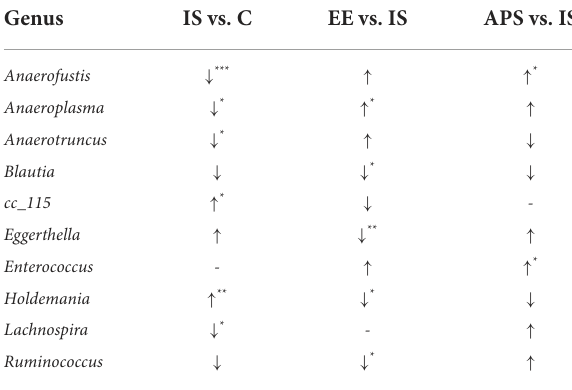
TABLE 1 Summary of genera with significant variation during the trial. Genus IS vs. C EE vs. IS APS vs.